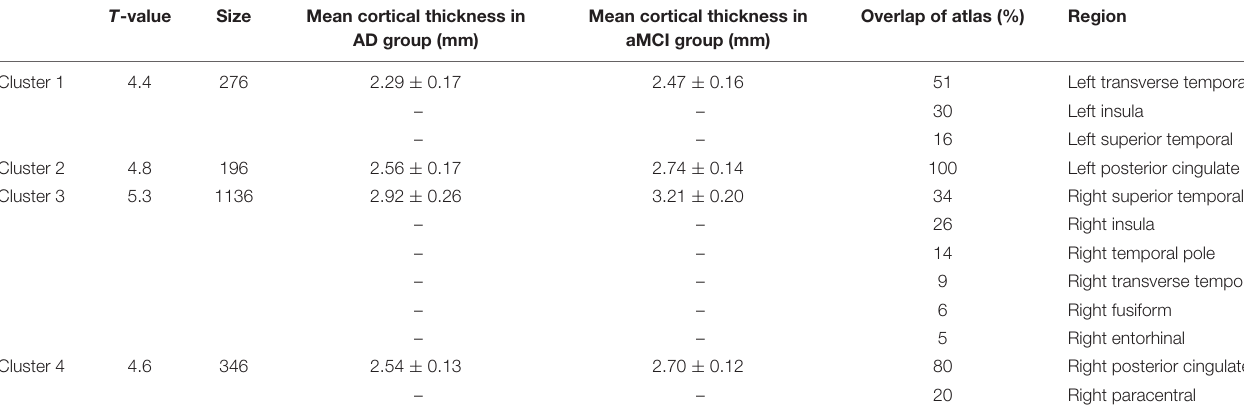
TABLE 3 | Brain regions with reduced cortical thickness in the AD-aMCI